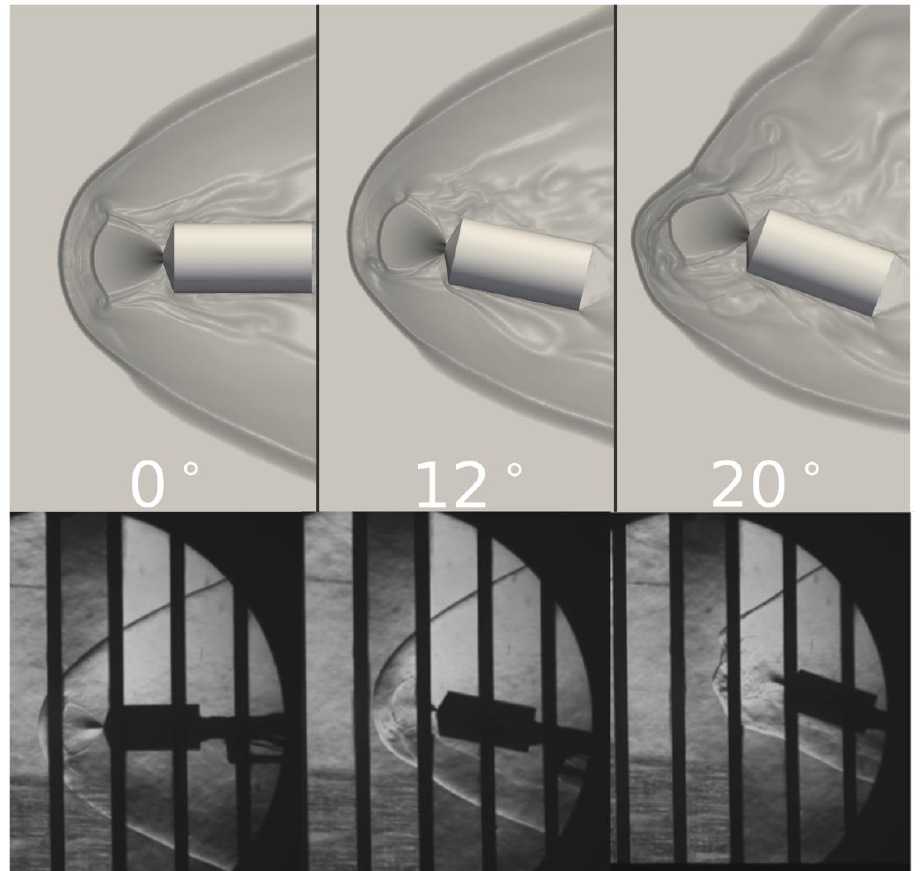
Figure 9. ( Top ): Log of density gradient centerline contours for BPANS CC model. ( Bottom ): Experimental schlieren [4].